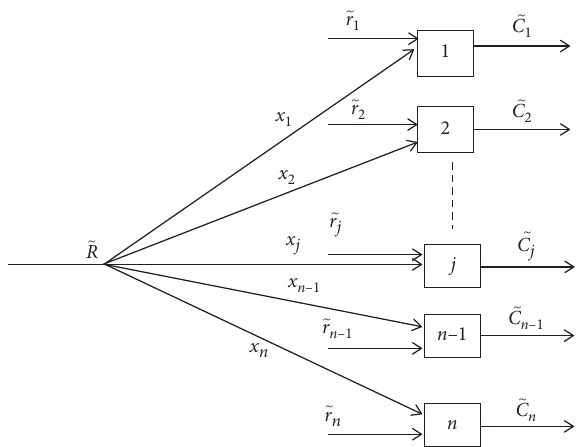
Figure 1: Jackson open-type data sending network over n parallel